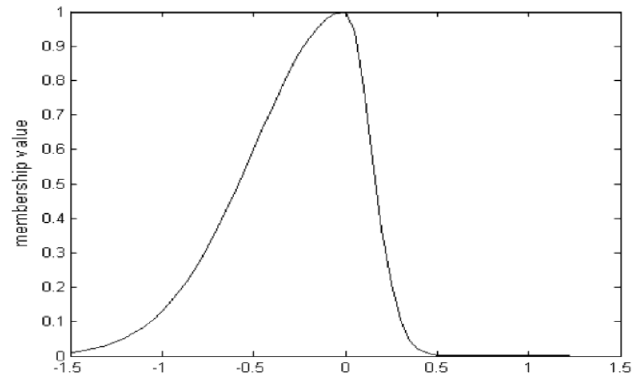
Figure 3. Structure of asymmetric membership functions (MF).